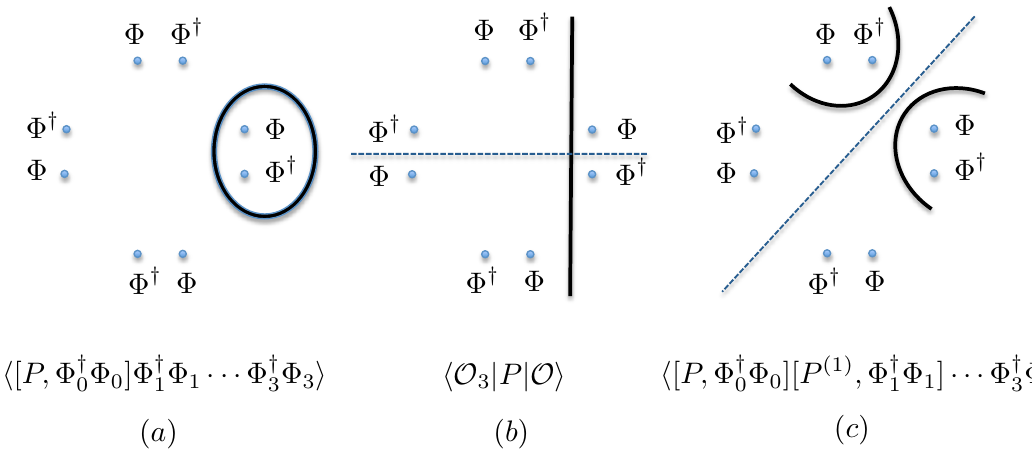
Figure 2 . (a) The (cid:12)rst derivative in shape deformation of the sandwiched R(cid:19)enyi divergence for n = 4. The commutator is represented with the charge written as an integral on the codimension one surface encircling the pair (cid:8) y (cid:8) 0 . (b) Same commutator with the charges written on a di(cid:11)erent 0 surface, (c) A term that appears at the second order in deformation which is re(cid:13)ection symmetric around (cid:18) = (cid:25)= 2. Note that P (1) is the same as P but rotated by (cid:25)=